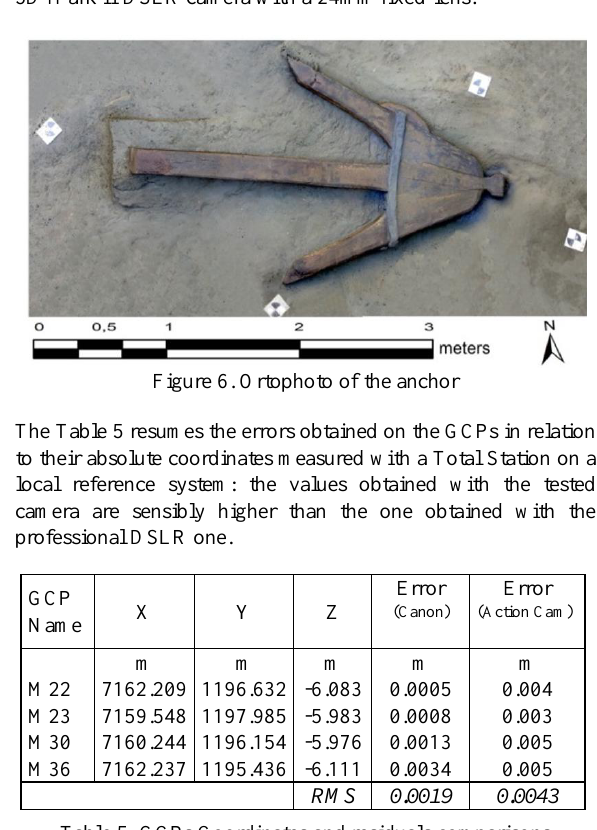
Table 5. GCPs Coordinates and residuals